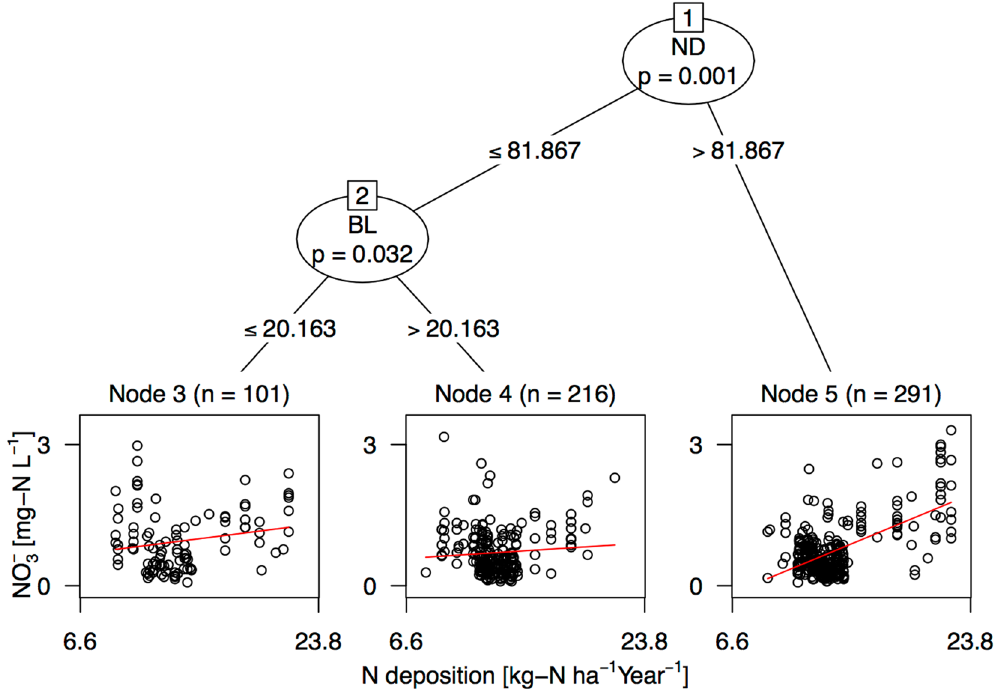
Figure 4. Recursively partitioned linear regression model of − NO